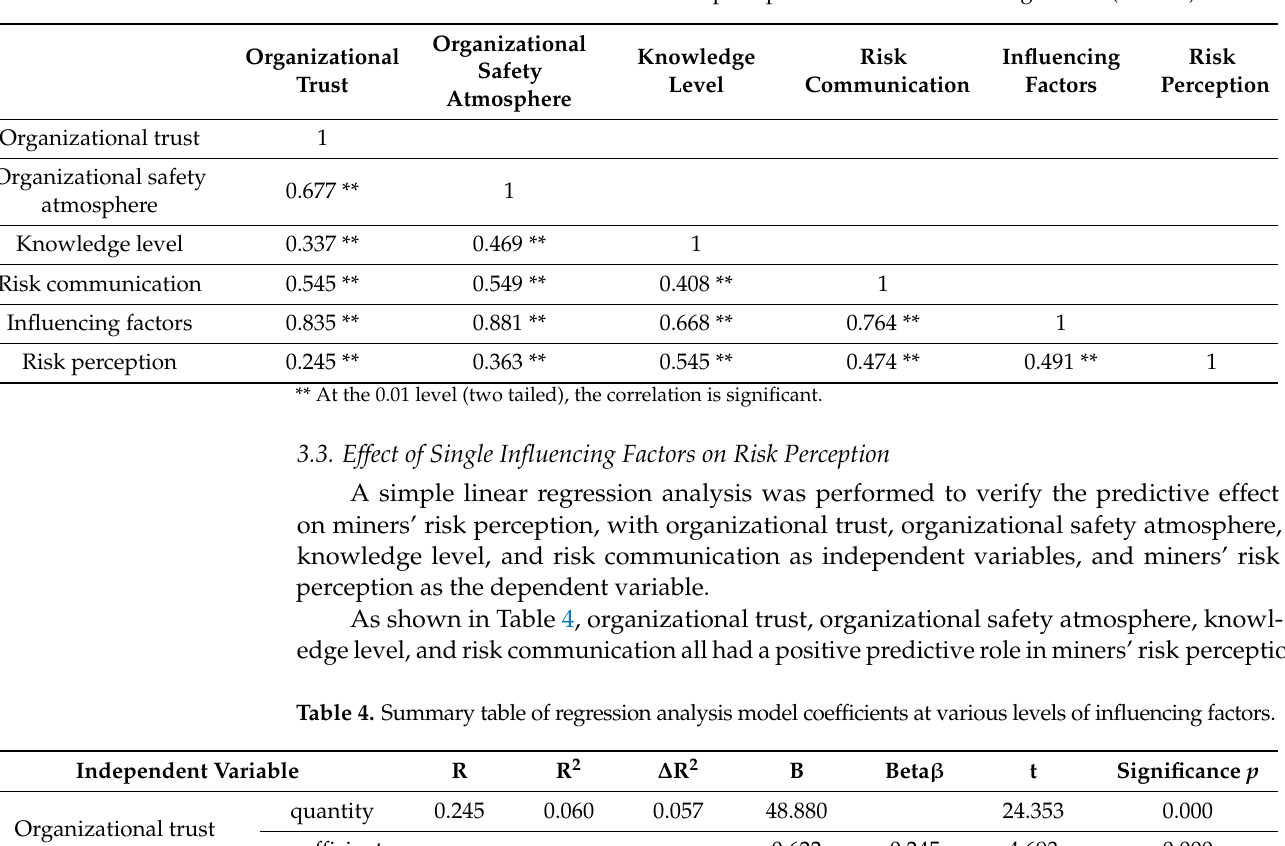
Table 3. Correlation between miners’ risk perception level and influencing factors ( n = 362).